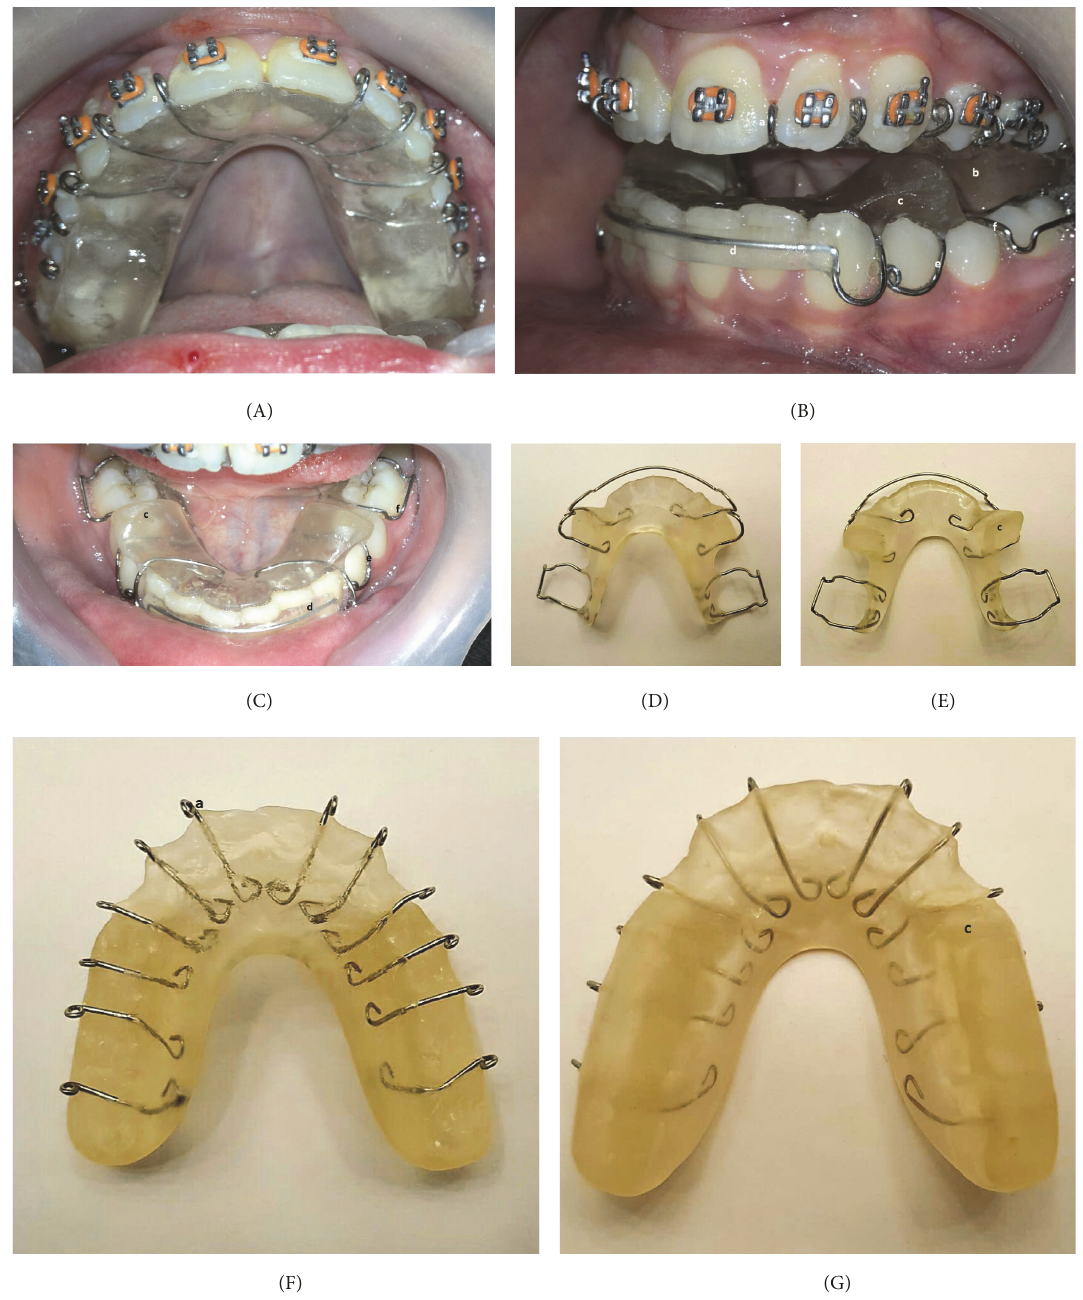
Figure 5: Twin Block appliance: maxillary part (A): (a) modified ball clasps used instead of conventional clasps to coordinate with fixed appliance;TwinBlockappliance(B):(b)blockA,(c)blockB,(d)labialbow,(e)Cclasps,and(f)Adam’sclasp;mandibularpart(C);mandibular part mucosal surface (D); mandibular part occlusal surface (E); maxillary part mucosal surface (F); maxillary part occlusal surface